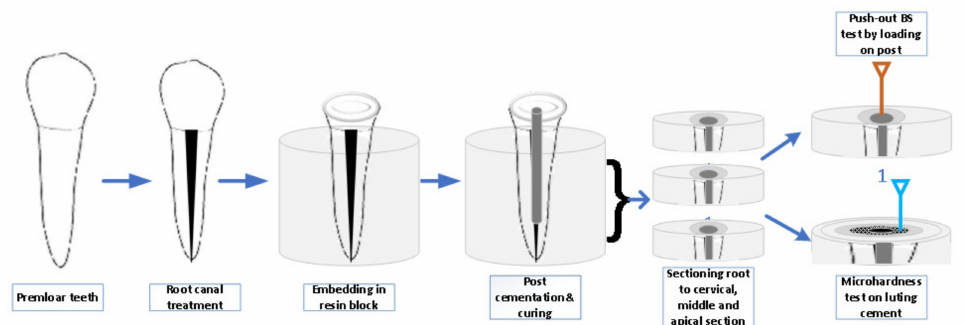
Figure 2. Push-out test and microhardness methodology flowchart. Ten teeth samples from each post group were utilized for the microhardness test. A coronal 1-mm teeth slice was sectioned and discarded to eliminate the effect of excess luting cement over tooth substrate. The teeth samples were sectioned at coronal, middle, and apical third with 4-mm thickness. The micro-indenter instrument (FALCON-500, INNOVATEST Europe BV, Borgharenweg, Maastricht, NL, Canada) was used to test the microhardness of luting cement in (Figure 3) each cross section. The microhardness test was performed over resin luting cement using Vickers digital micro-indenter, applying 200 gf with a retention time of 15 s. Each sample was tested at 3 different locations and an average value was expressed as the Vickers hardness number (VHN). The remaining ten samples from each group were subjected to 1500 thermocycling (1100; SD Mechatronik, Feldkirchen–Westerham, Germany) between 5 and 55 ◦ C with the dwell time of 30 s and transfer time of 10 s. Subsequently, the teeth samples were sectioned at the coronal, middle, and apical third. Two-mm slices from each cross section were utilized for the push-out bond strength. The sectioned samples with coronal parts facing down were placed over a universal testing machine (Instron, Norwood, MA, USA), and an apically directed load from one-mm diameter plunger at 0.5 mm/min speed was applied on the post (Figure 4). The force was applied until the post dislodged from a root canal and the maximum load was